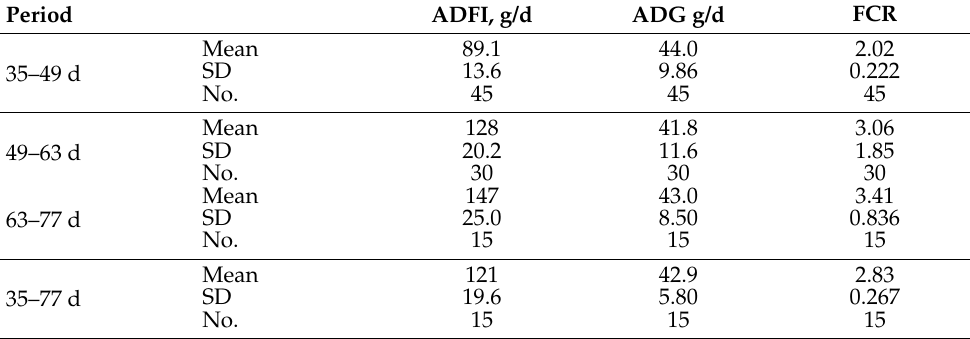
Table 3. Average daily feed intake (ADFI), average daily gain (ADG) and feed conversion rate (FCR) of the calibration-group animals from 35 to 77